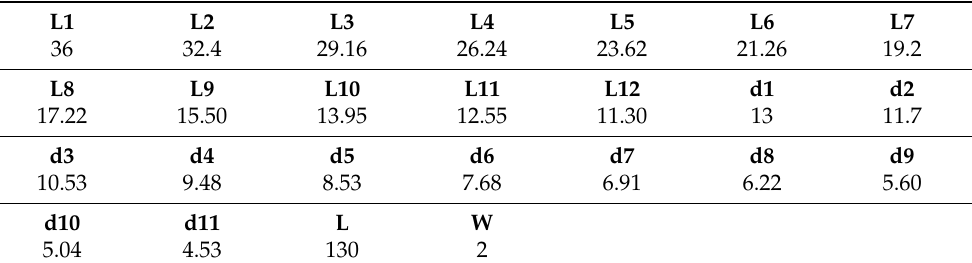
Table 3. Optimized log-period antenna size (mm).